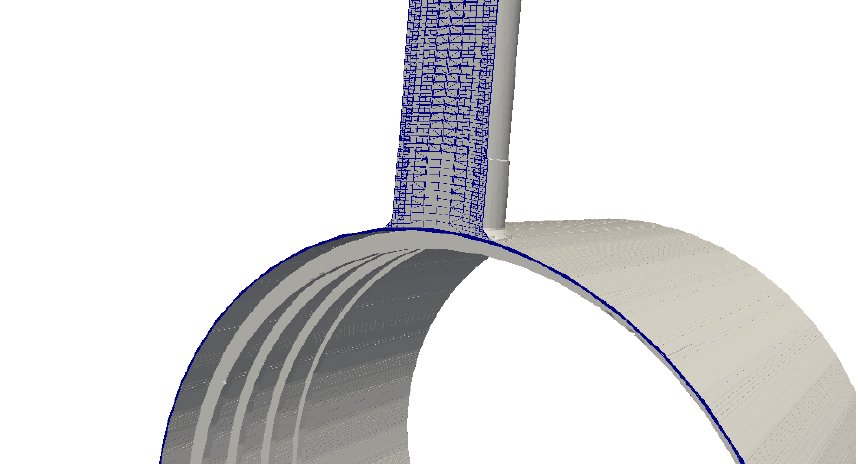
Figure 4. Mesh for gap between piston and cylinder, and outlet